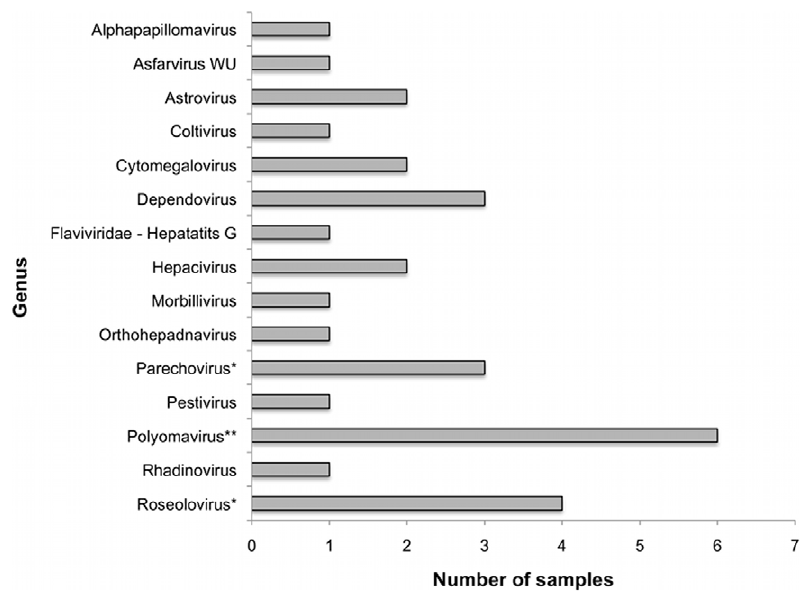
Figure 4. Viruses detected by sequencing that were not screened by PCR. The bars represent the number of samples in which each virus was detected by sequencing. *Indicates viruses that were not assayed by PCR in NP samples. **Indicates a virus that was not assayed by PCR but belongs to a genus with members that were.